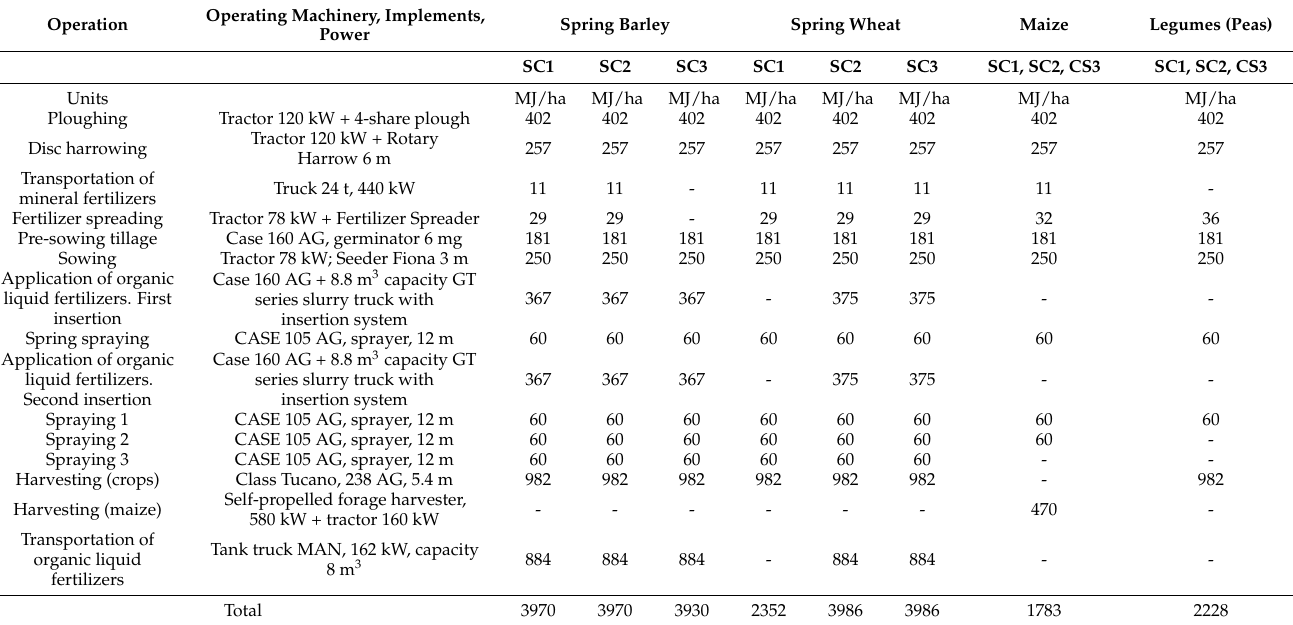
Table 4. Field machinery operational characteristics and energy input (MJ/ha) for three